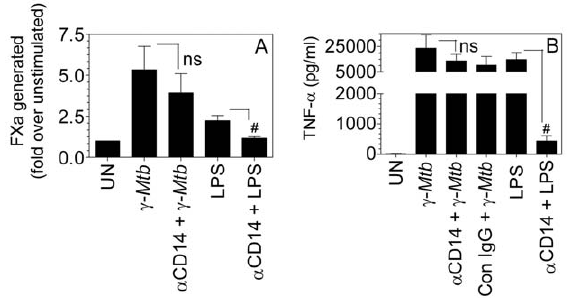
Figure 4. c -Mtb -mediated TF induction and TNF- a secretion is mostly independent of CD14. MDMs were either treated with c - Mtb H37Rv (10 m g/ml) for 9 h or LPS (100 ng/ml) for 6 h in the presence or absence of CD14 blocking antibodies (10 m g/ml) (where CD14 antibody was added, the cells were preincubated with it for 45 min before stimulation). At the end of stimulation period, cell free supernatants were collected for TNF- a ELISA and the cells were used to measure cell surface TF activity. ( A ) TF activity as measured in FXa generation. Data is depicted as fold increase in TF activity over control ( B ) TNF- a levels as determined in ELISA. ns, not statistically significant; # indicates statistically significant decrease compared to LPS alone ( P , 0.05). Data are mean 6 SEM